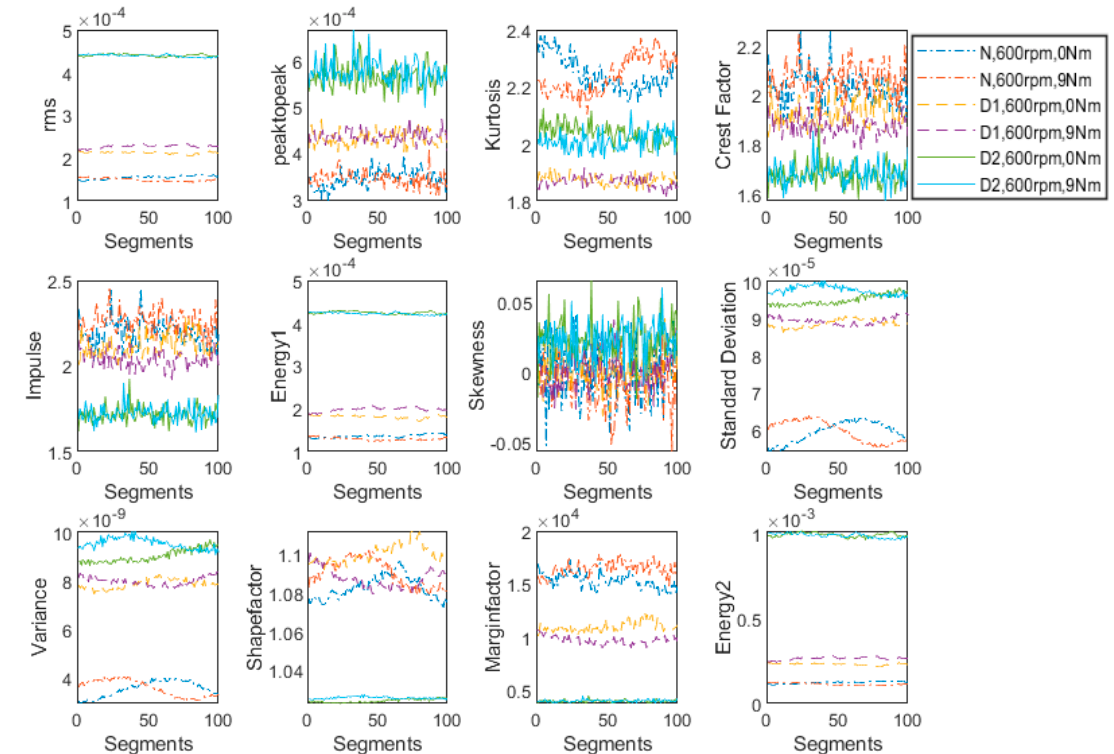
Figure 6. Features’ plot for normal, 1 tooth broken and 2 teeth broken gear boxes at constant speed (600 rpm) and changing load (0 Nm and 9 Nm).